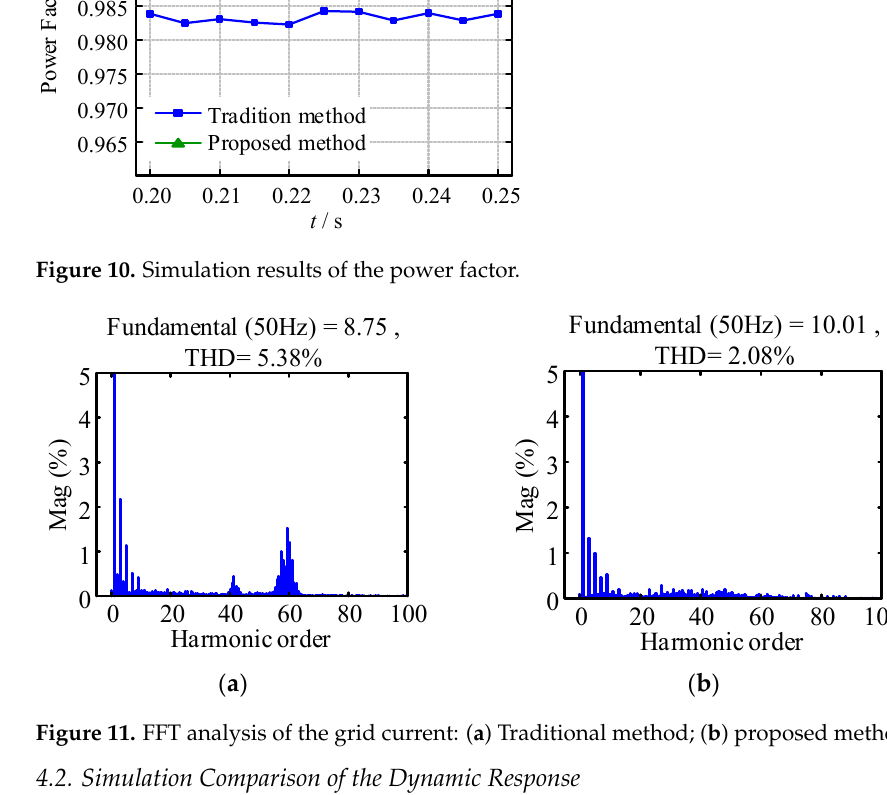
( b ) Figure 12. Simulation results comparison of the dynamic response performance: ( a ) Traditional method; ( b ) proposed method. 5. Experiment Research To further verify the effectiveness of the proposed control strategy, an experimental platform of the three-phase LCL grid-connected inverter was built as shown in Figure 13. Figure 13a shows an actual picture of the prototype, and Figure 13b shows a connection diagram. In the experiment, the three-phase AC power was connected to the inverter through the autotransformer T 1 . The algorithm was implemented by the 32-bit floating point dual-core processor TMS320F28377D of TI Company, and the dead time of PWM pulse signal was set to 3 μ s. A TEKTRONIX TPS2024 oscilloscope was used to observe the waveform, and a FLUKE 435 power quality analyzer was used to analyze the power qual- ity of the 3-phase grid-connected current.